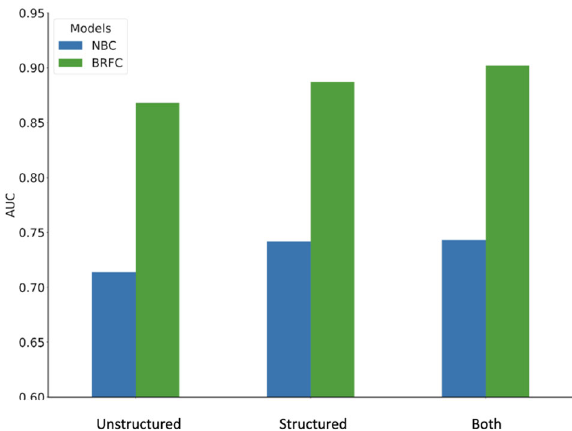
Fig. 4 Performance of NBC and BRFC models, by type of data used. BRFC models perform considerably better than NBC models in terms of AUC across all three datasets. Combining structured and unstructured data yields better performance than using structured data alone, which itself performs better than using unstructured data